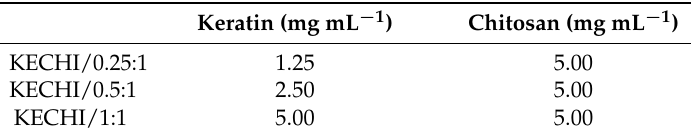
Table 1. Experimental design of keratin and chitosan-azide solution for membrane